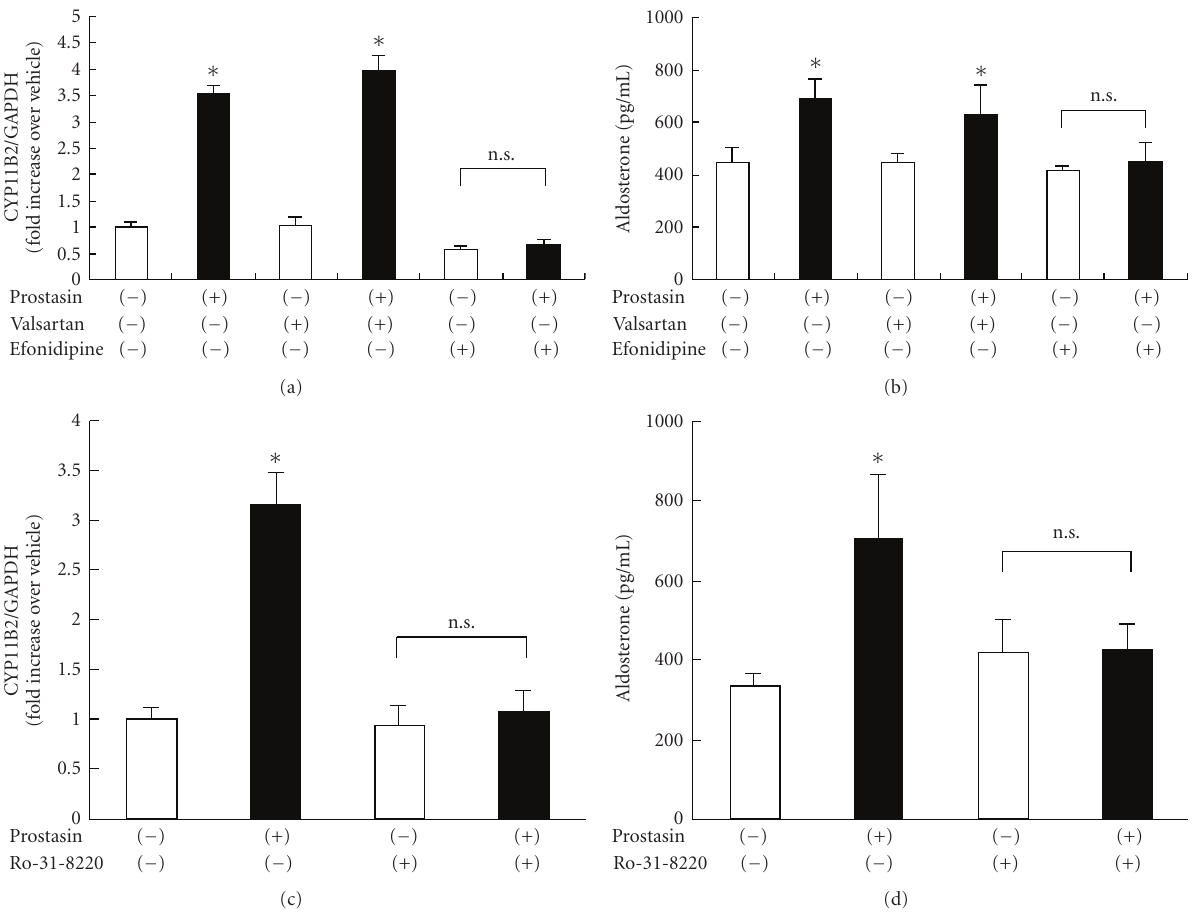
Figure 4: E ff ect of angiotensin II type 1 receptor blocker (a) and (b), T-type/L-type Ca 2+ channel blocker (a) and (b), or PKC ε inhibitor (c) and (d) on the prostasin-induced CYP11B2 expression and aldosterone production in H295R cells. Cells were treated with prostasin (400 μ g/mL) in the presence or absence of valsartan (100nM), efonidipine (100nM), or Ro-31-8220 (1¯M). CYP11B2 mRNA expression (a) and (c) was determined following 24-hour treatment, and aldosterone production (b) and (d) was evaluated following 48-hour treatment. Values are means ± SD ( n = 6). ∗ P < . 001 versus vehicle. n.s.: not